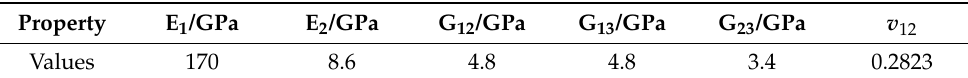
Figure 12. Flow chart of finite element analysis based on trajectory. Table 1. Basic mechanical property parameters of materials.